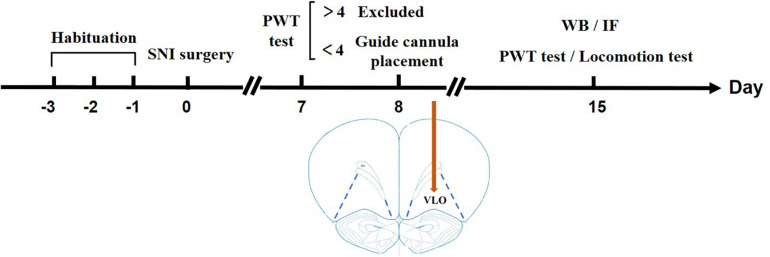
Timeline illustrating a summary of the experimental design. After habituation for 3 days, SNI surgery was performed on Day 0. On Day 7, a PWT test was performed to measure if the rats developed allodynia. If the PWT > 4.0 g, the rats were excluded from later experiments; if the PWT < 4.0 g, a guide cannula was placed in the VLO. After the surgery, the rats were in their homecage for 7 days to recover until Day 14. On Day 15, a second PWT or locomotion test was performed to measure the effect of drugs. For Western blotting or immunofluorescent staining, the rats were sacrificed on Day 15 without cannula placement.